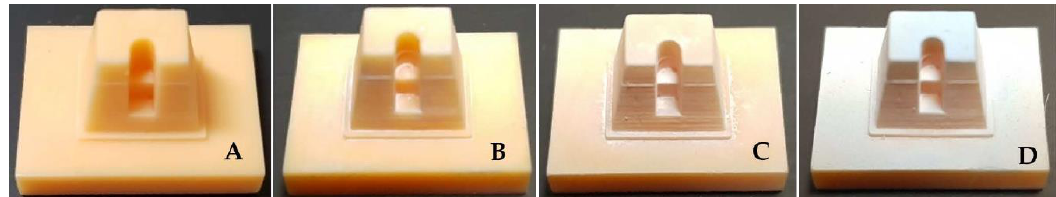
Figure 7. The inlay reference models with no treatment and 3 different scanning aid materials. ( A ) no treatment; ( B ) ScanCure; ( C ) IP; ( D ) VITA.